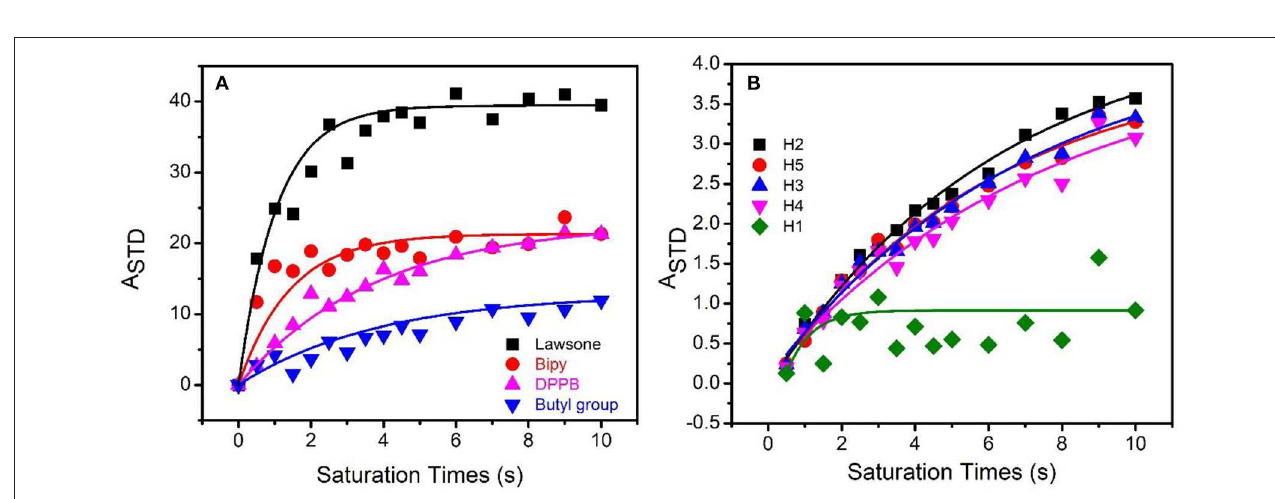
FIGURE 6 | Built-up curves of A STD against saturation time at 298K and 600 MHz ( 1 H nucleus) for CBLAU (5mM) (A ) and for the individual lawsone (5mM) (B) in the presence of CT-DNA (50 µ